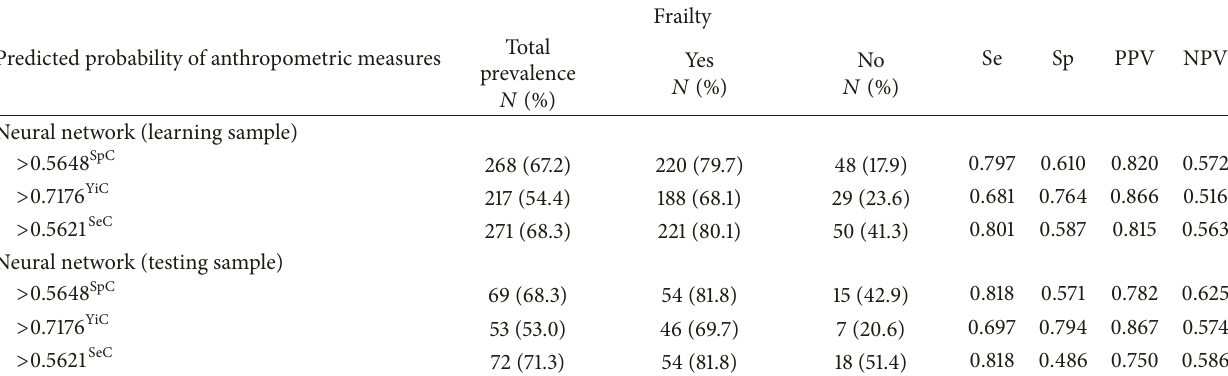
Table 4: Prognostic ability of anthropometric measures as predictors of frailty in older adults who were assisted at primary health care centers via artificial neural